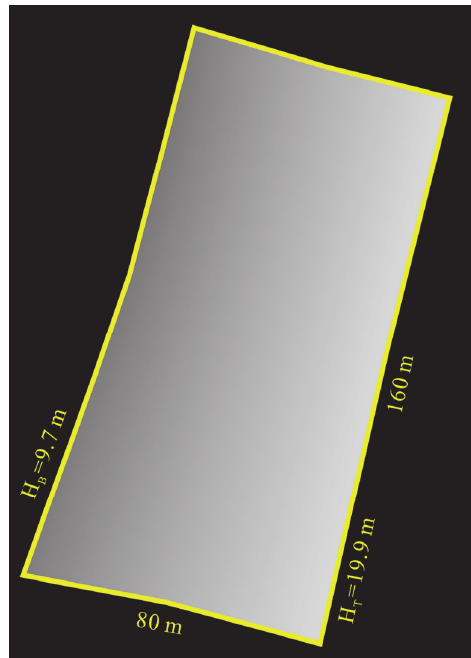
Figure 3. DSM obtained by TLS